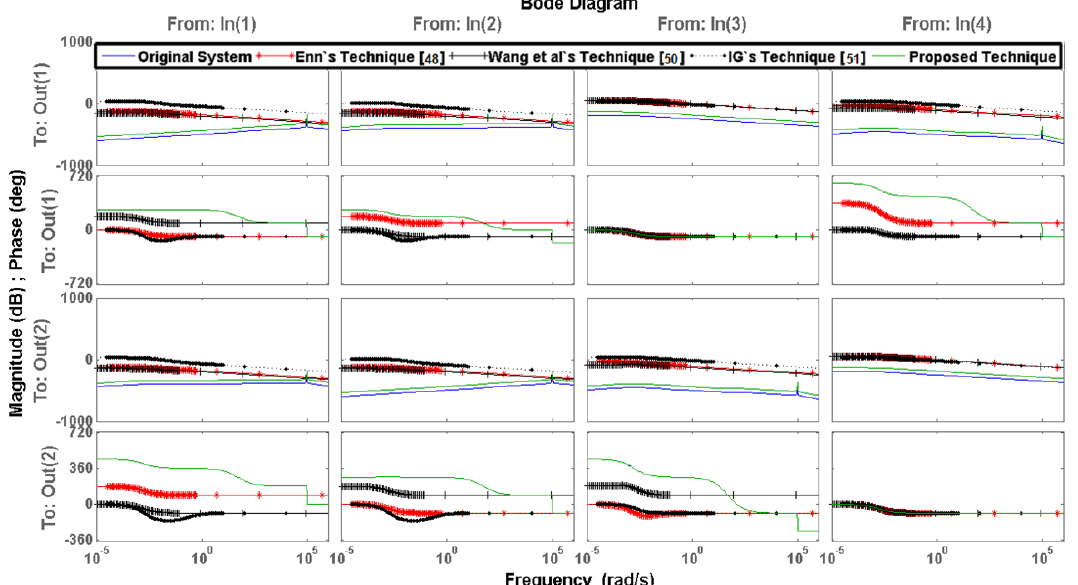
Figure 8. Frequency response Bode plot (magnitude and phase) in the given frequency weights of 2nd order for Example